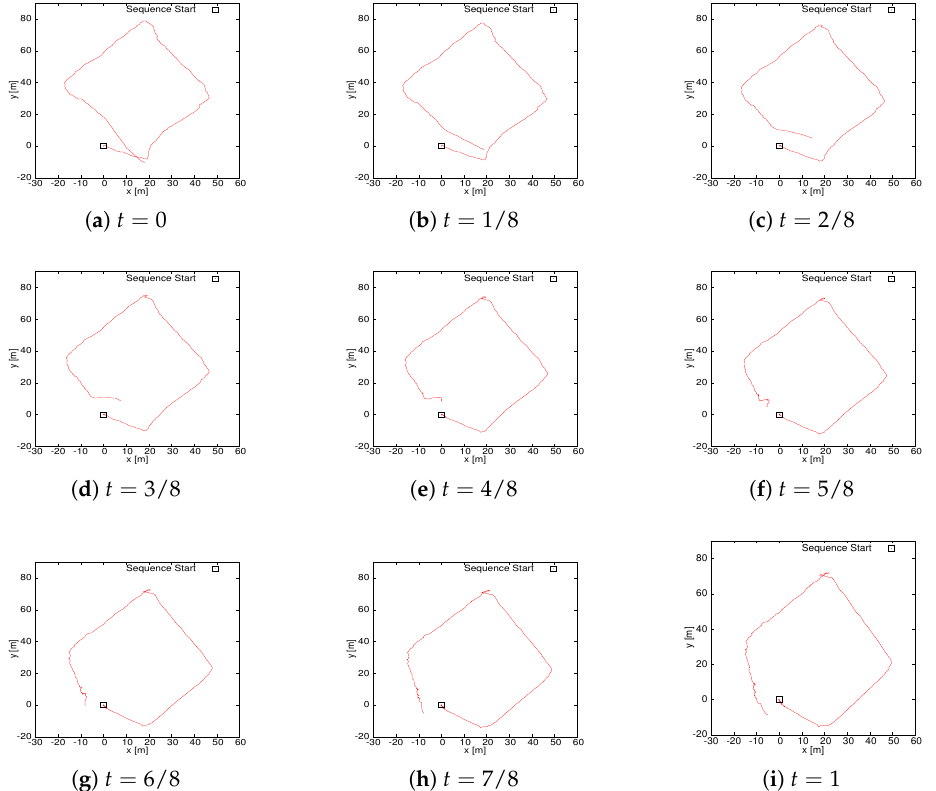
Figure 5. Fused trajectories. The box marks the starting point. t = 0: original GPS trajectory. t = 1: initial trajectory from HectorSLAM. The rest of the figures are a series of fusion trajectories. All curves are from the ZAE data